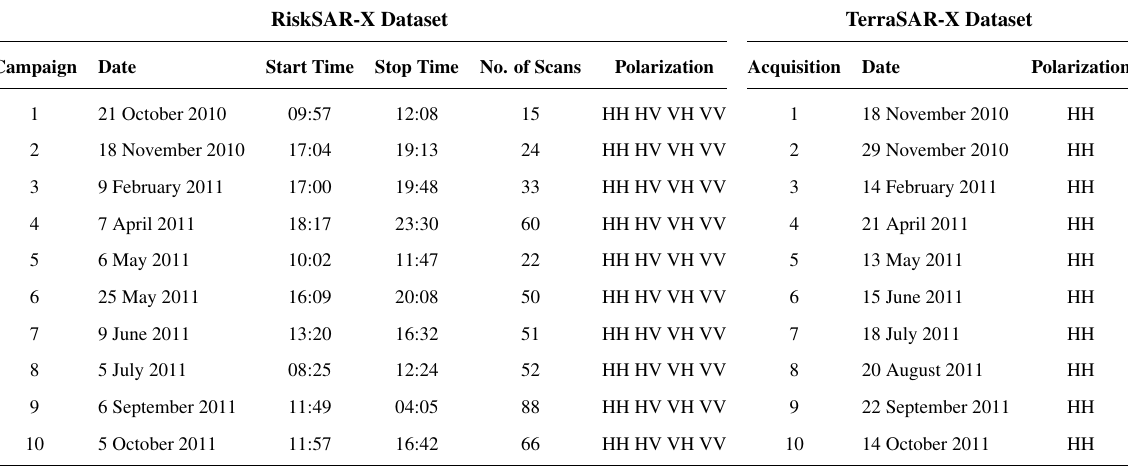
Table 2. Timetable of the RiskSAR-X measurements campaigns and the TerraSAR-X acquisitions. RiskSAR-X Dataset TerraSAR-X Dataset Polarization Acquisition Date